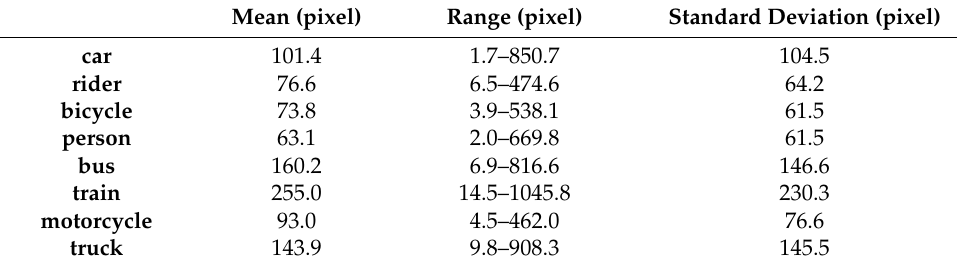
Table 3. The scale statistics results of each instance class in the Cityscapes